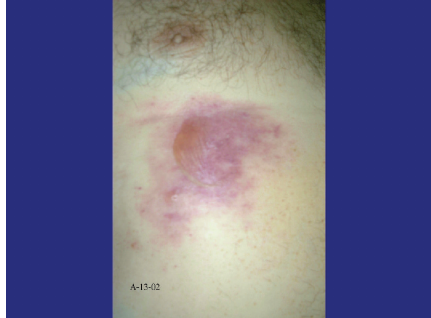
Figure 1: Superficial burn blisters with epidermal loss on non- exposure areas.